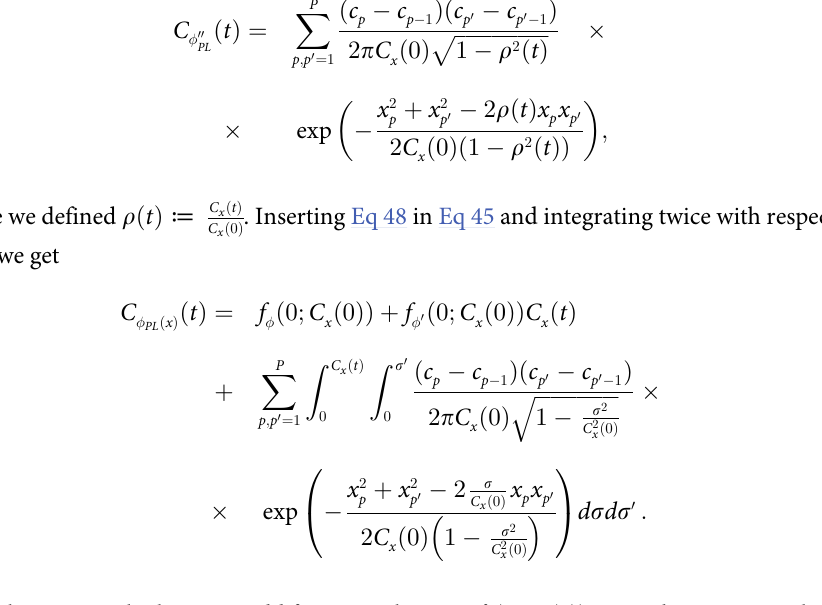
ffiffiffiffiffiffiffiffiffiffiffiffiffiffiffiffiffiffi p 1 (cid:0) r 2 ð t Þ